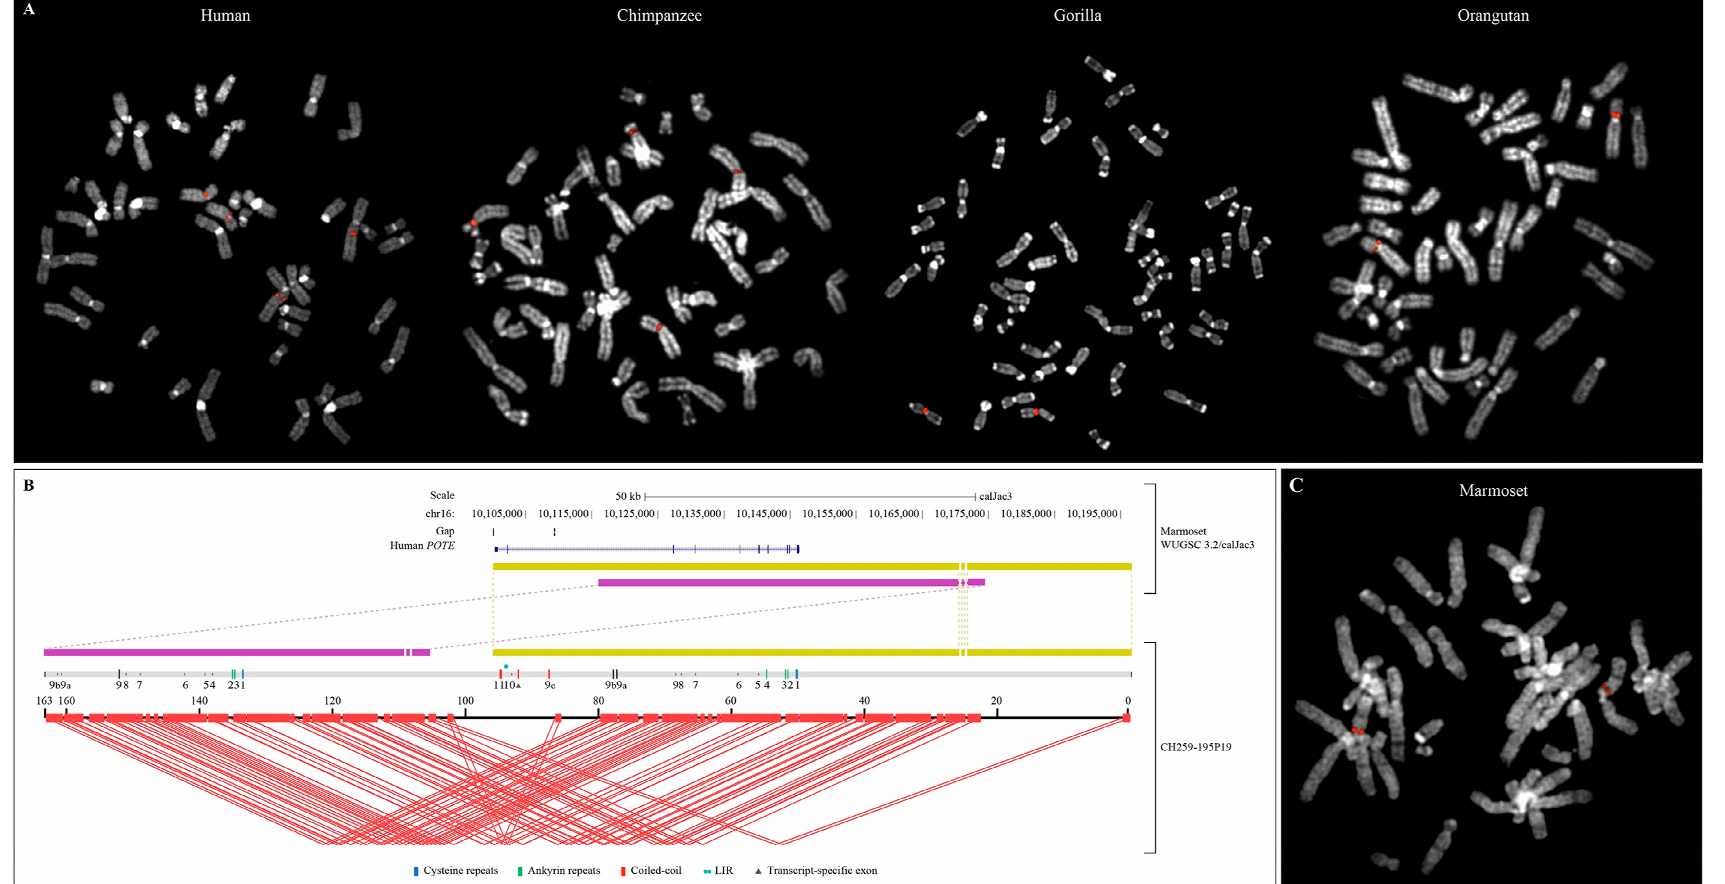
Figure 3. ( A ) FISH validation of the fosmid clone ABC12-49207800H13 (in red) in human, chimpanzee, gorilla, and orangutan. ( B ) Parasight view of the CJA BAC CH259-195P19. Red lines show internal duplications. The gray bar indicates the POTE gene content, with coding (colored) and noncoding (dark gray) exons shown as vertical bars. Yellow and purple blocks show the most continuous portion (96 kb) of the marmoset reference genome where the BAC maps. The human POTE RefSeq mapping is shown in blue. ( C ) FISH results of the clone CH259-195P19 (in red) in marmoset.